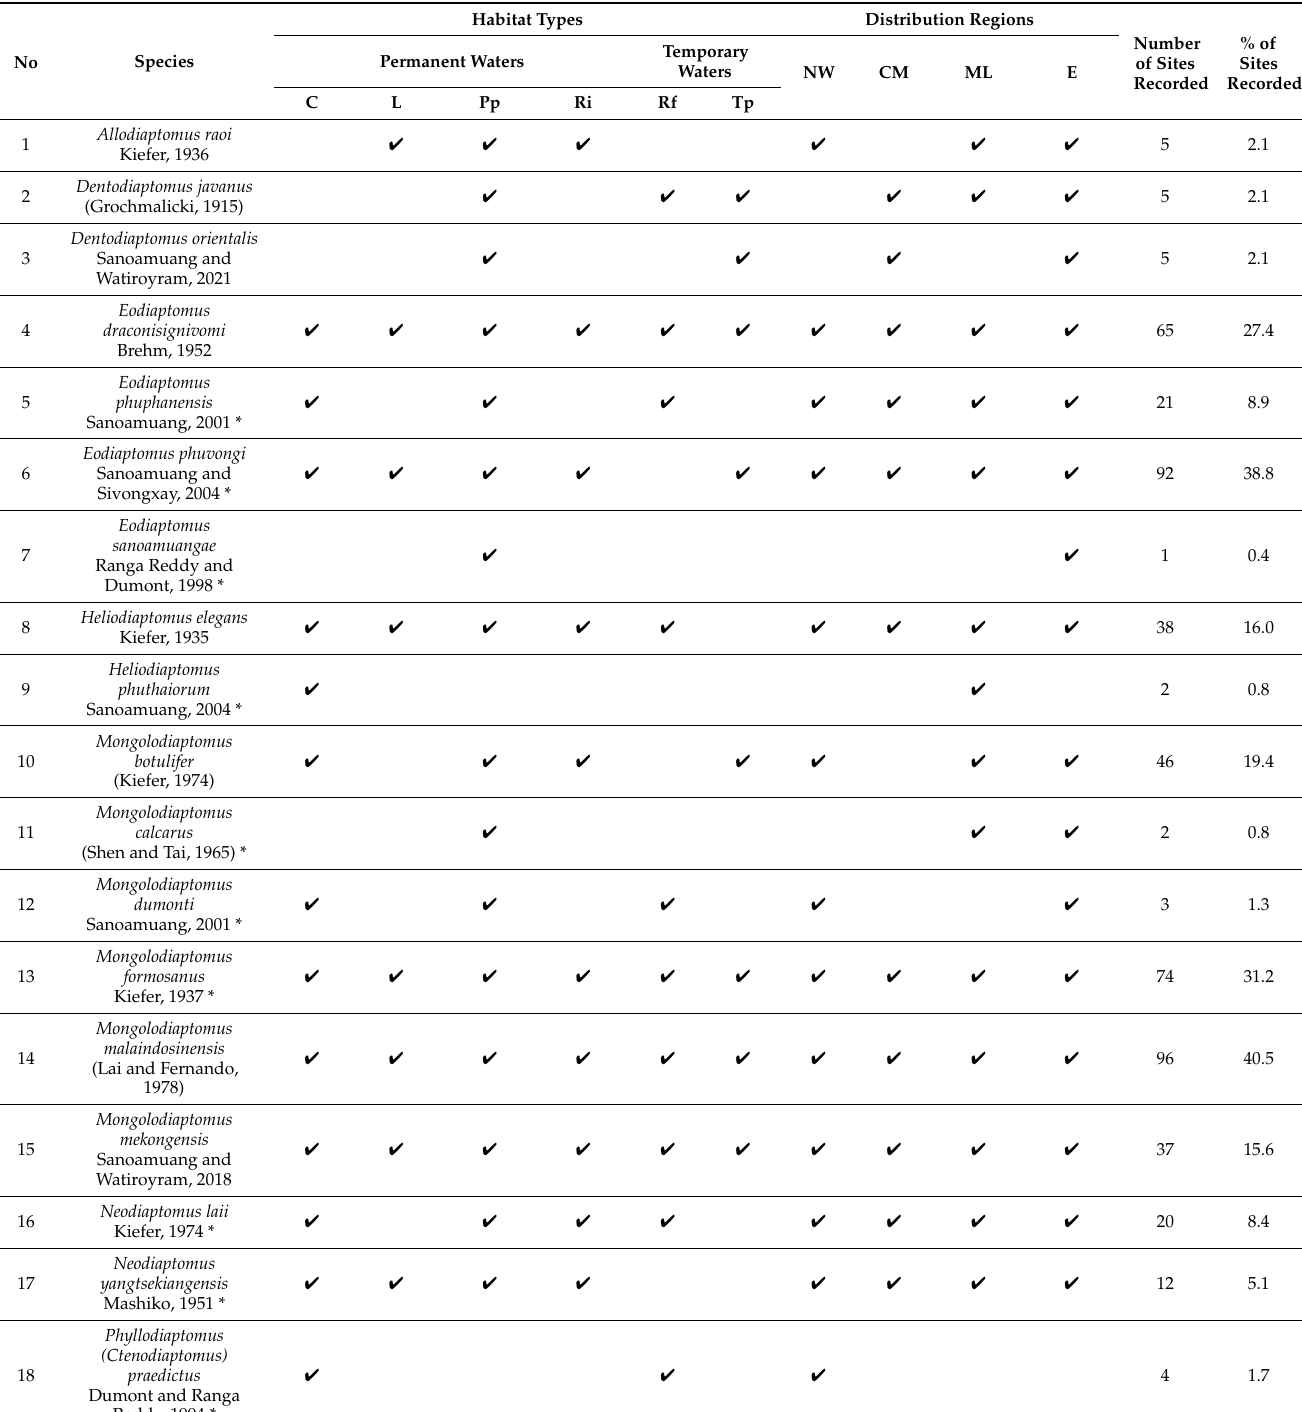
Table 2. List of the diaptomid copepods recorded during the present study with their habitat types, and distribution regions in the freshwater habitats of Cambodia. Abbreviations of habitat types and distribution regions are given in the caption of Table 1. Species marked with an * are new records for